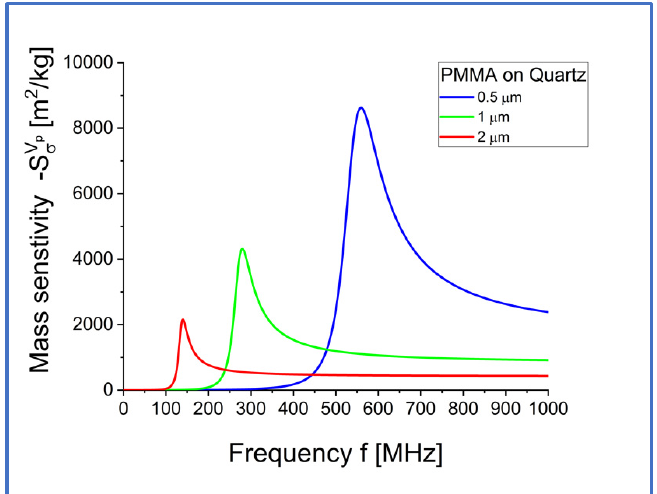
Figure 5. Coefficient of mass sensitivity S m 2 /kg for Love surface waves propagating in waveguides loaded with a semi-infinite Newtonian liquid with an equivalent surface mass den-sity σ = ρ 0 δ 0 /2, as a function of frequency f , for different values of thickness h 1 of the elastic surface layer ( h 1 = 0.5, 1 and 2 µ m )